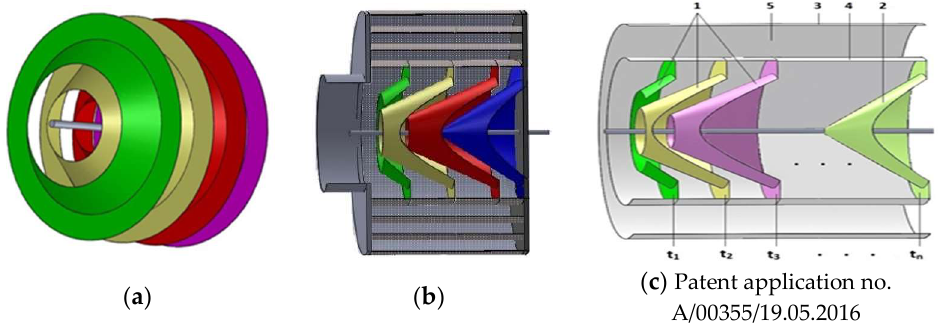
Figure 7. Section from the three-dimensional projection of the cylindrical baffled unit. ( a ) Baffled unit design; ( b ) baffled unit with cylindrical case section; ( c ) baffled unit section for how many cones are needed depending on dryer length.